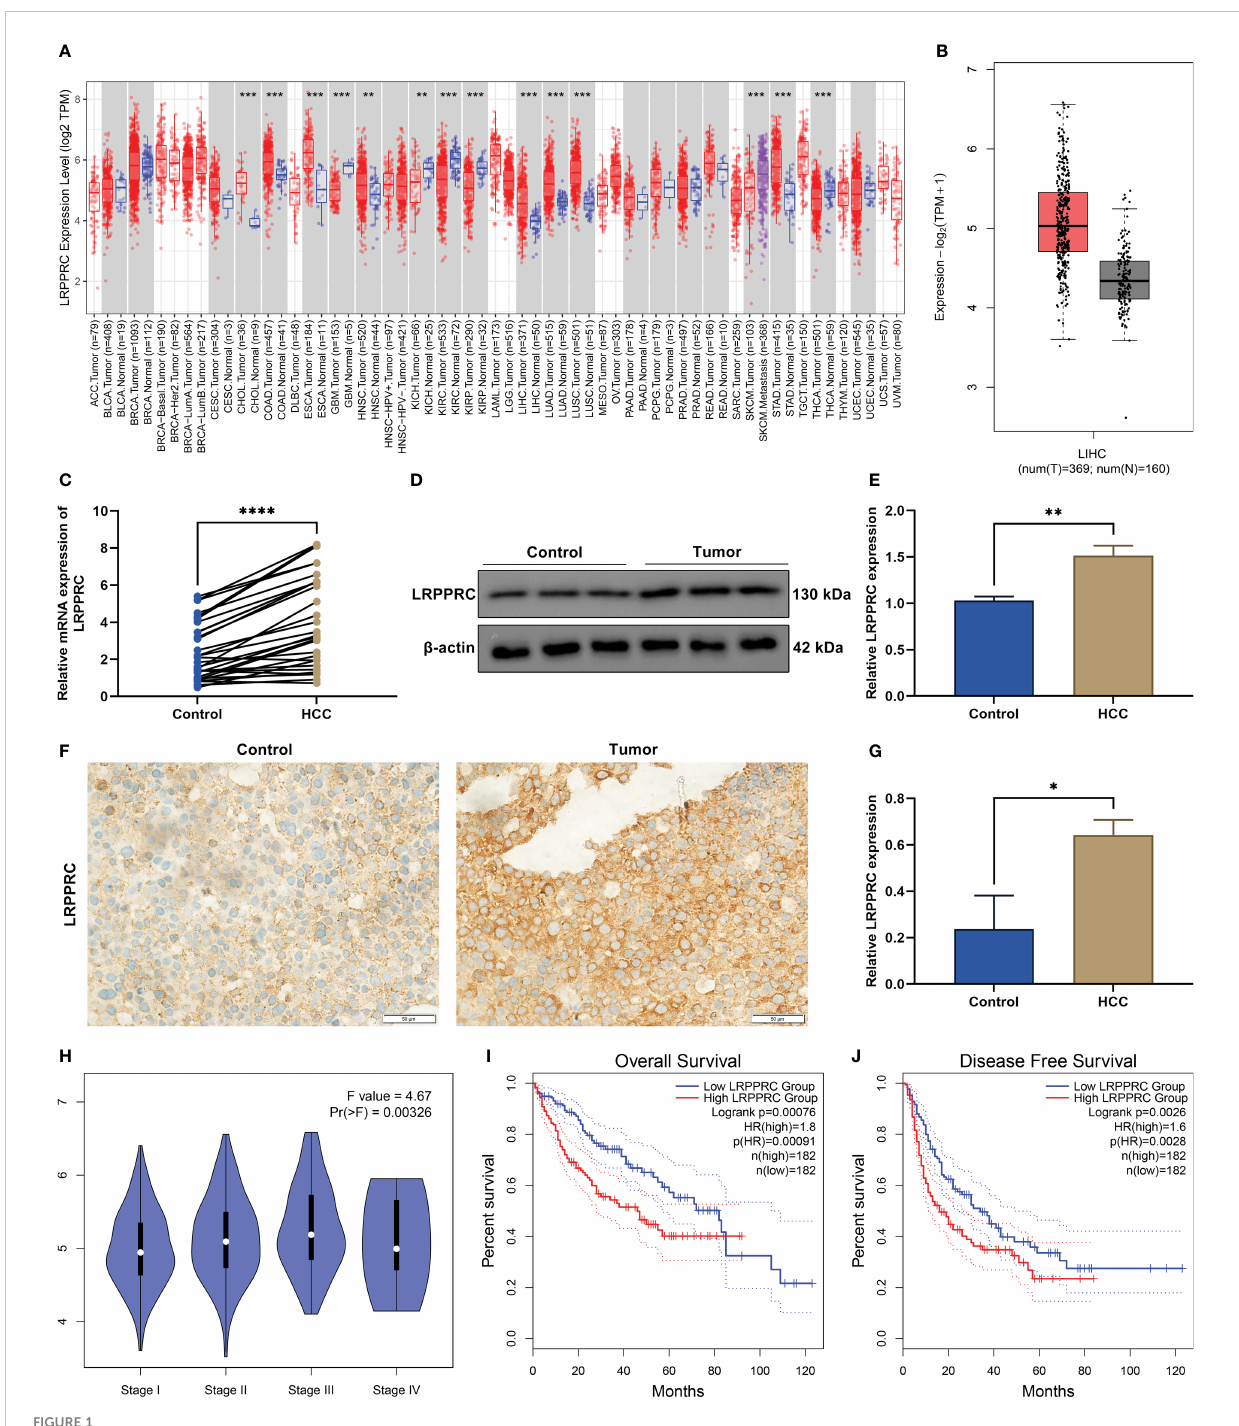
tissues. (B) LRPPRC level in HCC and control specimens across TCGA-LIHC patients. (C) RT-qPCR of the transcript level of LRPPRC in paired HCC and control tissues. (D) Representative immunoblotting images of LRPPRC expression in such kinds of tissues. (E) Quanti fi cation of LRPPRC expression in line with the immunoblotting gray value. (F) Representative immunohistochemical staining photographs of LRPPRC in HCC and controls. (G) LRPPRC expression quanti fi cation in above tissues. (H) Difference in the transcript level of LRPPRC among distinct tumor stages of TCGA-LIHC patients. (I , J) Overall survival and disease-free survival probabilities of patients with lowly or highly expressed LRPPRC. * p < 0.05; ** p < 0.01; *** p < 0.001; **** p <